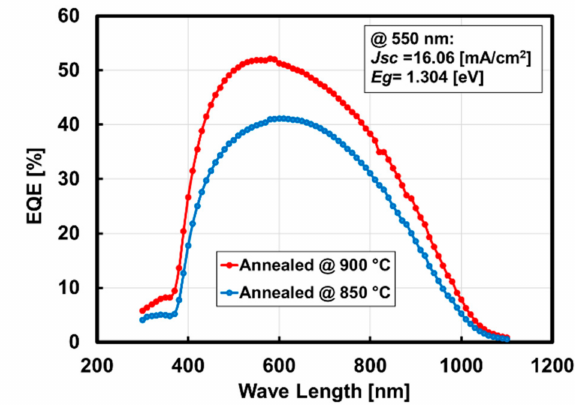
Figure 12. EQE responses of the solar cells fabricated by CuIC micro-Si thin film.